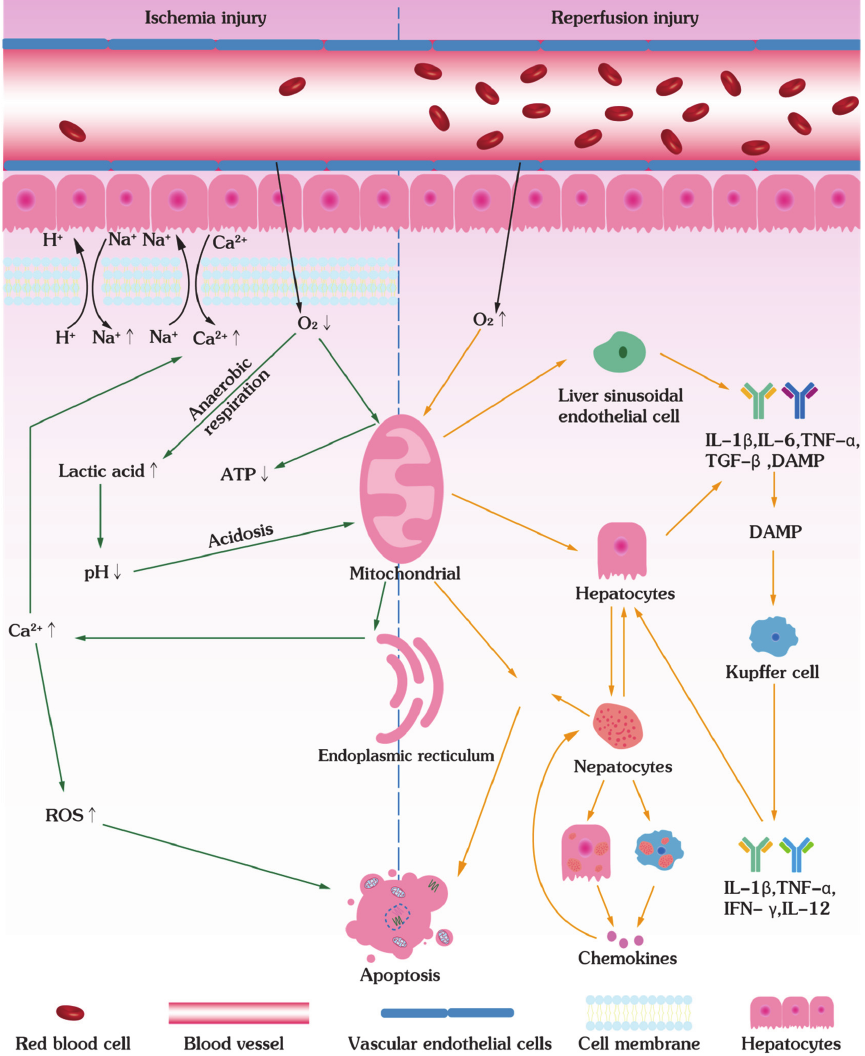
Figure 4. Mechanisms involved in hepatic ischemia–reperfusion injury. The figure on the left illustrates the mechanism of ischemic injury: intracellular PH decreases due to the lack of oxygen, acidosis, and hypoxia jointly lead to acute mitochondrial damage. The increase in intracellular Ca 2+ also increases ROS. The right side shows a reperfusion injury mechanism: the number of molecules attached to hepatic sinusoidal endothelial cells increases acutely; they are damaged and release various inflammatory factors, leading to various inflammatory responses in hepatic cells and an increase in ROS levels that eventually leads to cell apoptosis.